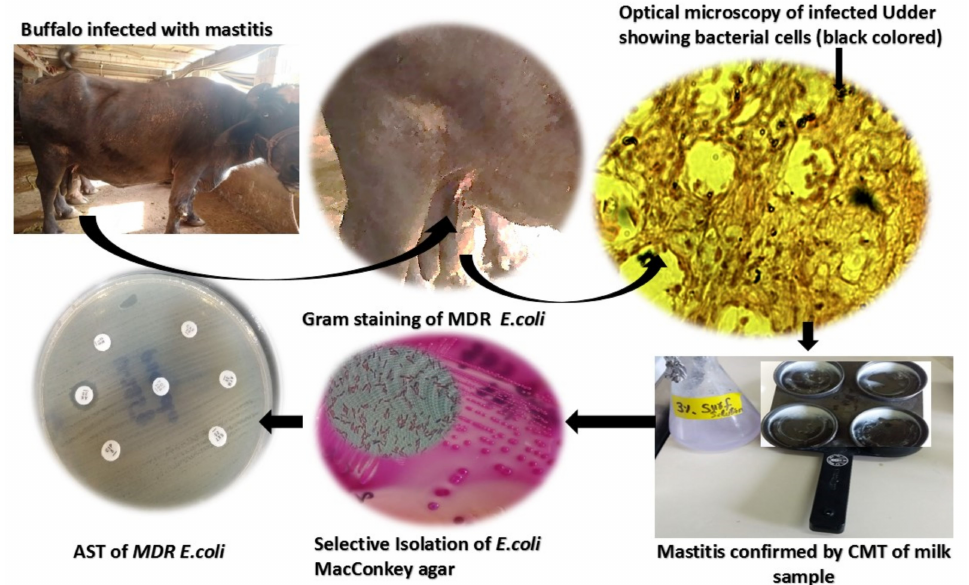
Figure 1. Isolation of multidrug-resistant (MDR) E. coli as causative agent of mastitis-induced udder infections in